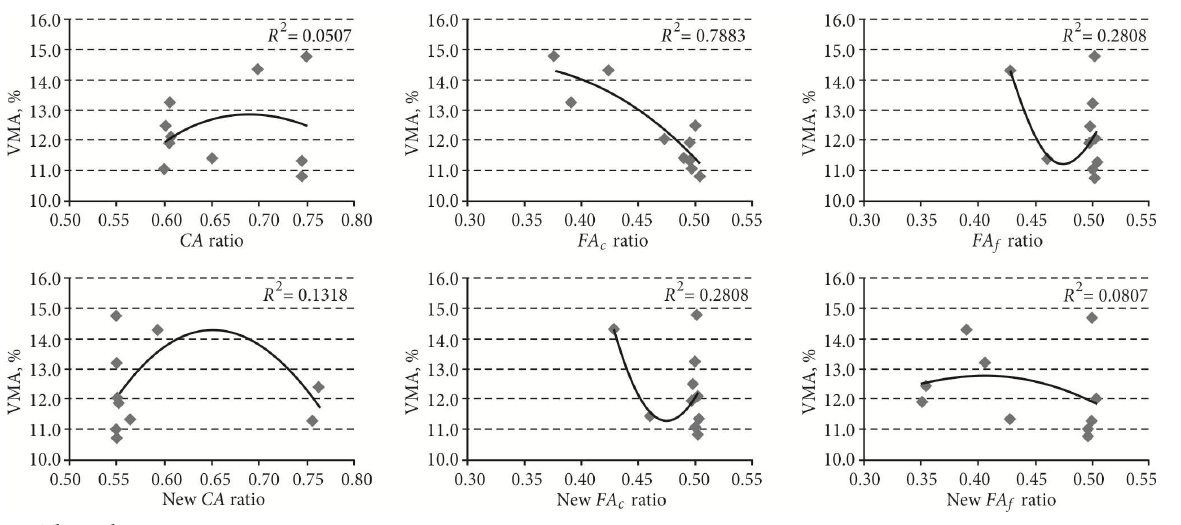
Fig. 3. The Bailey ratios versus VMA Table 6. The difference in VMA due to change in the new Bailey ratios and percent passing the PCS Difference between blends Difference in PCS